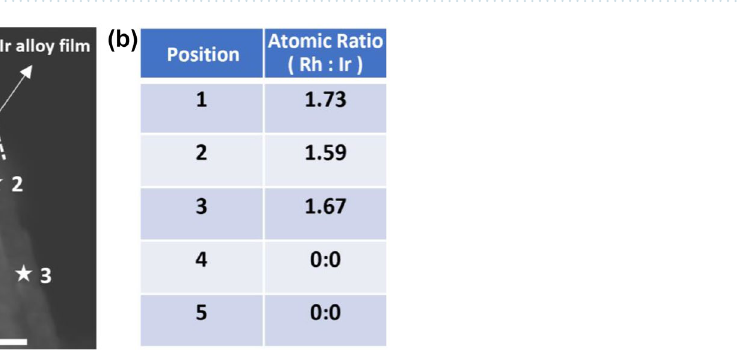
Figure 3. Low magnification EDX elemental maps of Rh–Ir thin film: ( a – c ) before EJH; ( d – f ) after EJH.